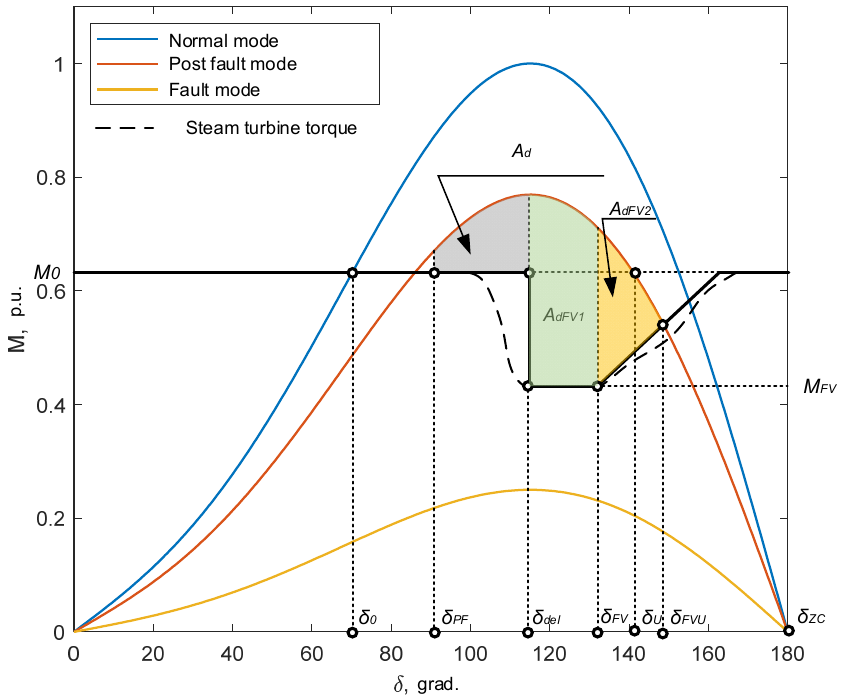
Figure 3. Angular characteristics of SG in the implementation of TFV.